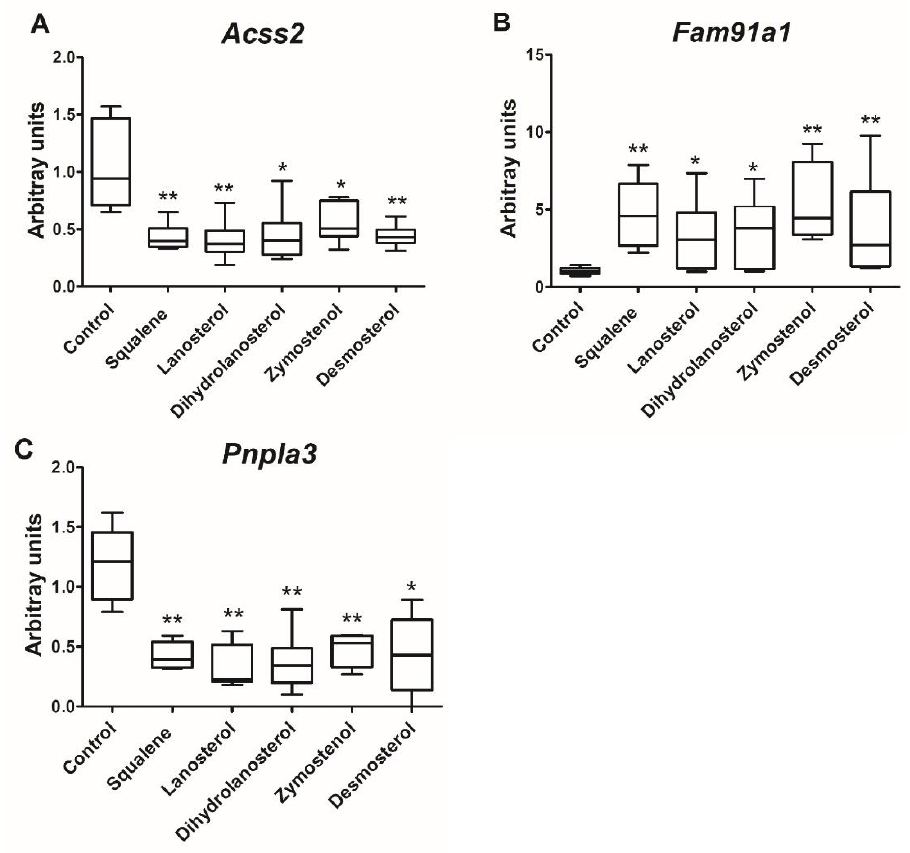
Figure 8. Effect of in vitro incubation of cholesterol precursors on selected gene expressions. AML12 cells were incubated in presence of 0.1% ethanol (control) or 200 µM squalene, 200 nM lanosterol, dihydrolanosterol, zymostenol or desmosterol dissolved in 0.1% ethanol for 6 h. The experiment was performed in triplicate, with n = 6 in each experiment for control and treated cells. Panels ( A – C ) correspond to Acss2 , Fam91a1 and Pnpla3 mRNA levels normalized to Pipb by RT-qPCR, respectively. Data are means and 10 – 90% percentiles. Statistical analyses were performed according to Mann –Whitney’s U-test. * p < 0.05, ** p < 0.01 vs. control.